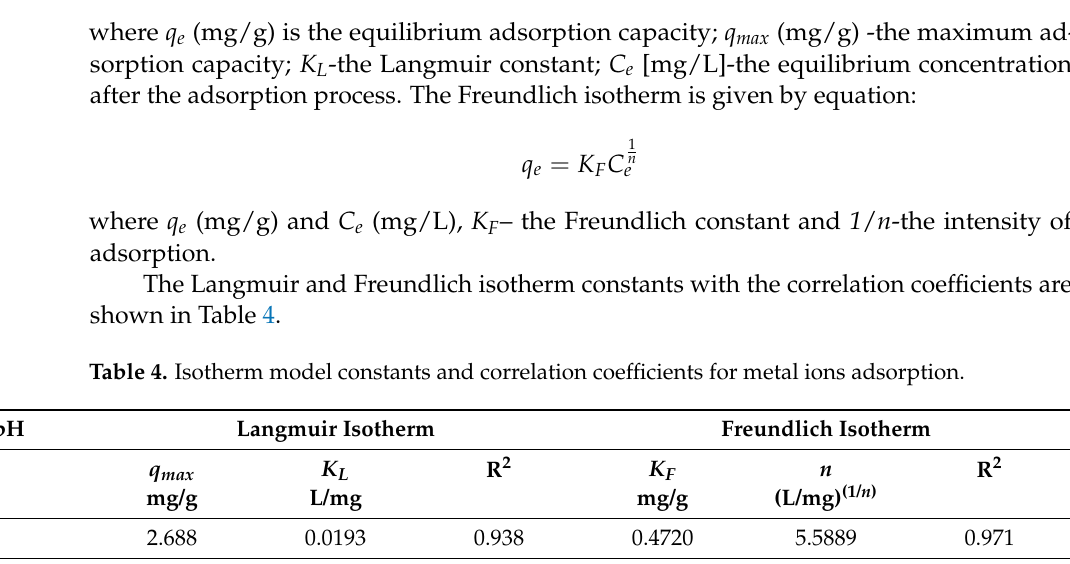
Figure 9. Effect of contact time on the pH of solutions during adsorption of Cu(II) ( ◆ ), Pb(II) ( ◼ ) Figure 10. Adsorption isotherms of Cu(II) ( Figure 10. Adsorption isotherms of Cu(II) ( ◆ ), Pb(II) ( ◼ ) and Cd(II) ( ▲ ) ions onto hybrid monolith and Cd(II) ( ▲ ) by hybrid monoliths GS 2:1: initial Cu(II) concentration 10 ppm, mass of adsorbent monoliths 0.32 ± 0.02 g, initial pH 4 and temperature 23 ± 1 °C.